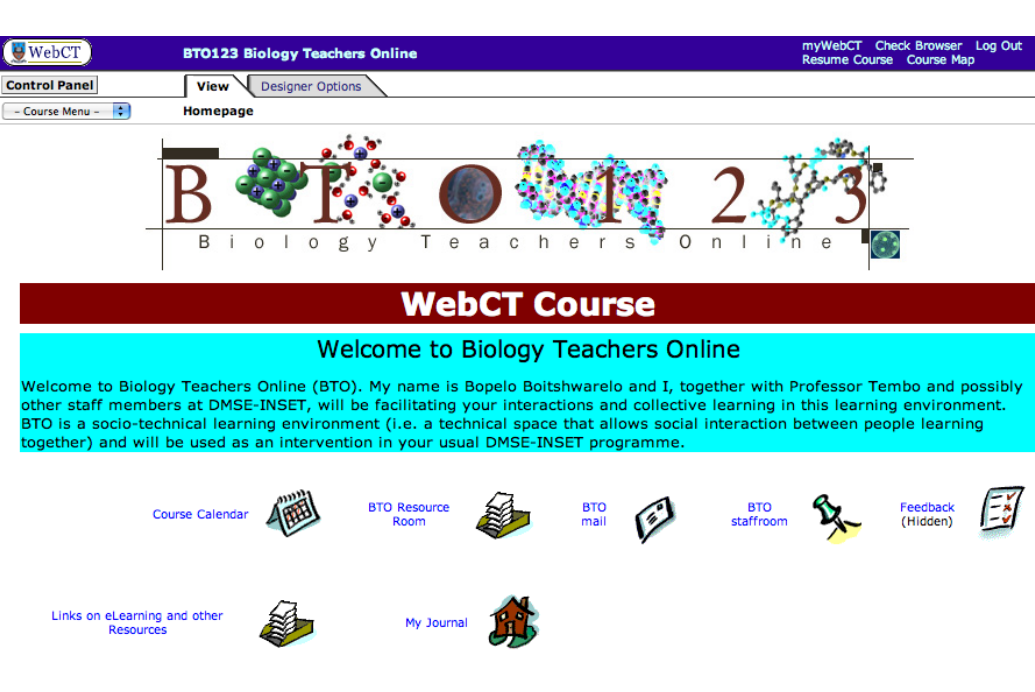
Figure 1 . Part of the BTO